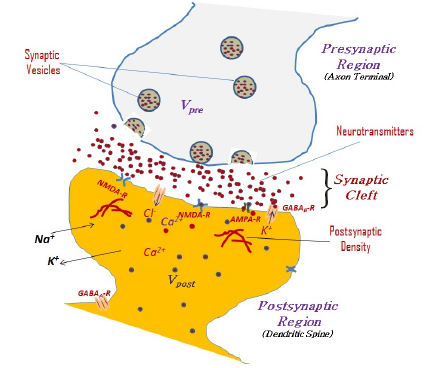
Figure 1. Pre and postsynaptic mechanism in neurons. Activity on the presynaptic terminal fuses synaptic vesicles and neurotransmitters are released into the synaptic cleft. These transmitters bind with the receptors on postsynaptic membrane and enter into the cytosol to change the transmembrane potential. Spines are believed to restrict diffusion of ions. As such they form biochemi- cal compartments that can encode changes in the state of an individual synapse without necessarily affecting the state of synapses of the same neuron